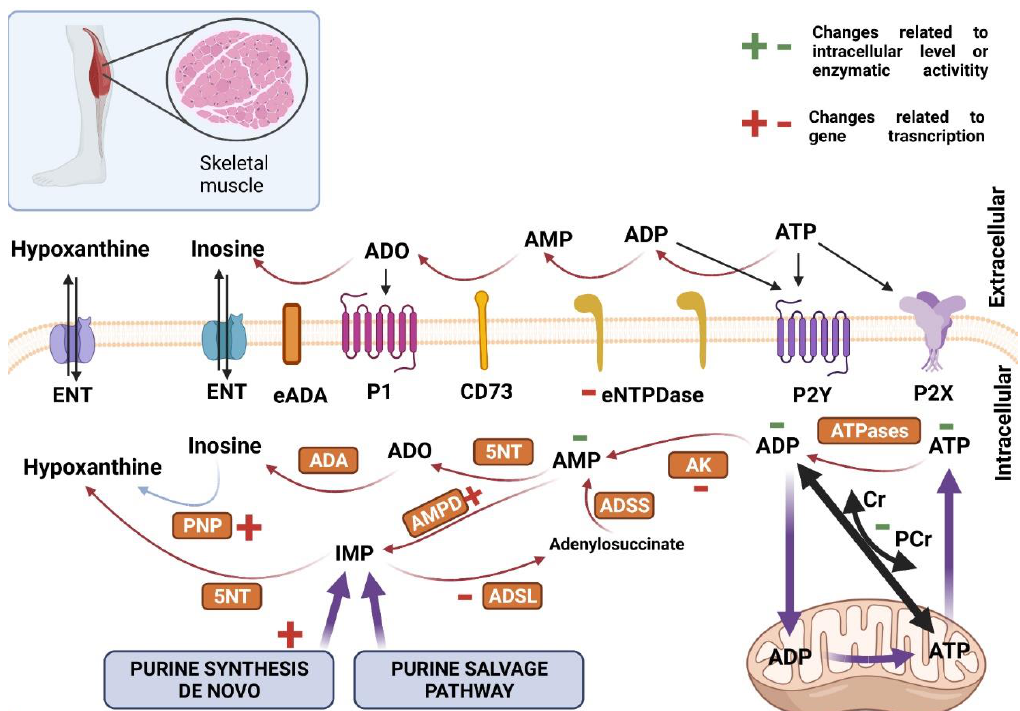
Figure 2. Purine metabolism and signaling in healthy and Huntington’s disease skeletal muscles. In the skeletal muscles, ATP is heavily produced by mitochondria and transported to the cytosol through the phosphocreatine shuttle. In the cytosol, many enzymes (orange boxes) can convert ATP to AMP, ADO, IMP, inosine, and hypoxanthine. The later ones can be transported to the extracellular milieu by ENT. Extracellularly, ATP can be converted to inosine through a similar cascade by extracellular-faced enzymes anchored to the cell membrane. CD73 is the only extracellular 5NT. Pathophysiology of Huntington’s disease exerts alterations in the activity of enzymes (marked in green +/ − ) or by genomic expression (marked in red +/ − ). P1 —Adenosine receptor; P2X —ATP receptor channel; P2Y —ATP/UTP receptor; ATPases